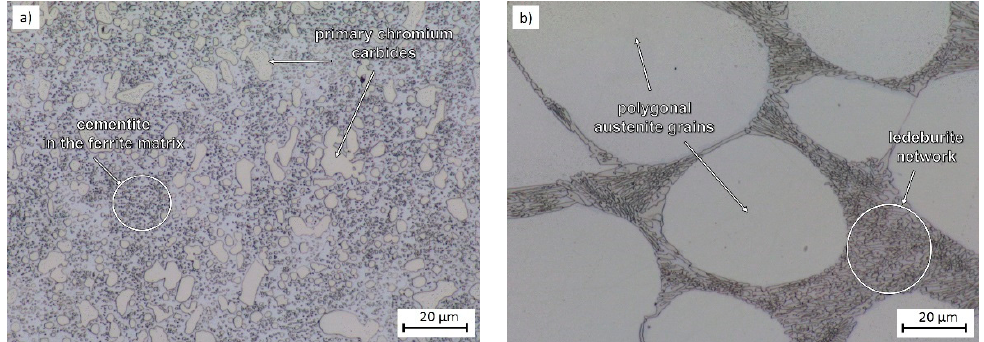
Figure 1. ( a ) As-received condition of the X210Cr12 steel: primary Cr 7 C 3 carbides and fine cementite in a ferritic matrix, light microscope; ( b ) semi-solid processed microstructure, soaking temperature: 1240 °C, polygonal austenite grains, ledeburite network, light microscope.